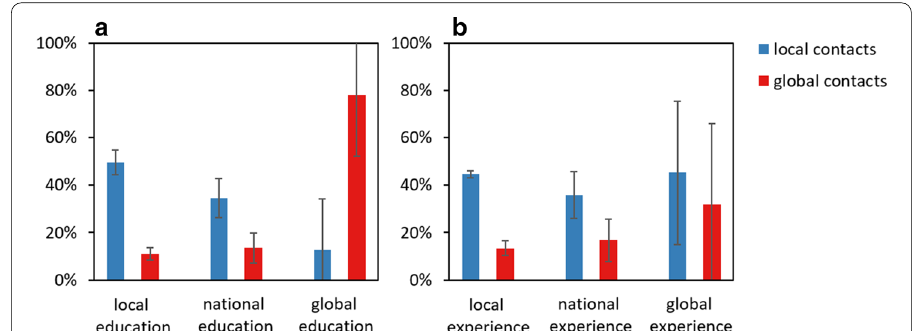
Fig. 6 Share of local and global contacts by education and work experience. a Fractions calculated by education categories of workers. Bars denote mean, and whiskers denote calculated by categories of work experience. Bars denote mean, and whiskers denote Individuals with local work experience are embedded in local networks but global work experience does not make networks more